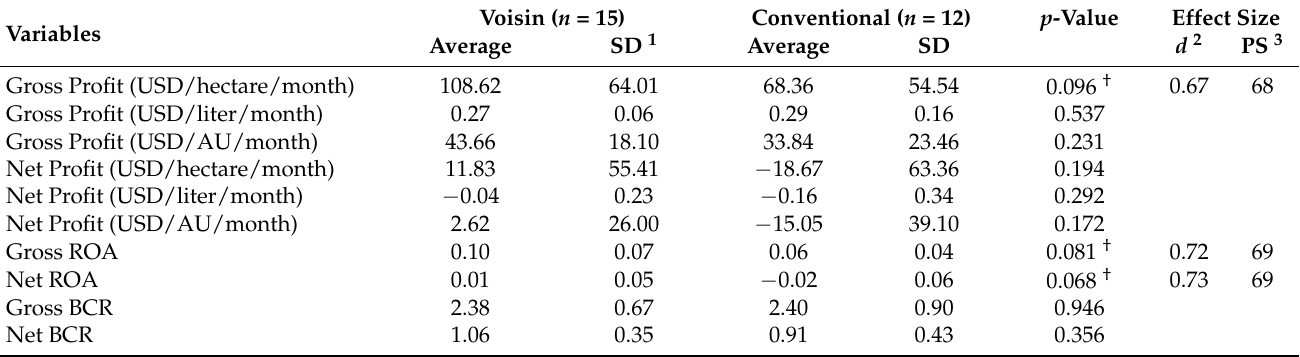
Table 9. Profitability